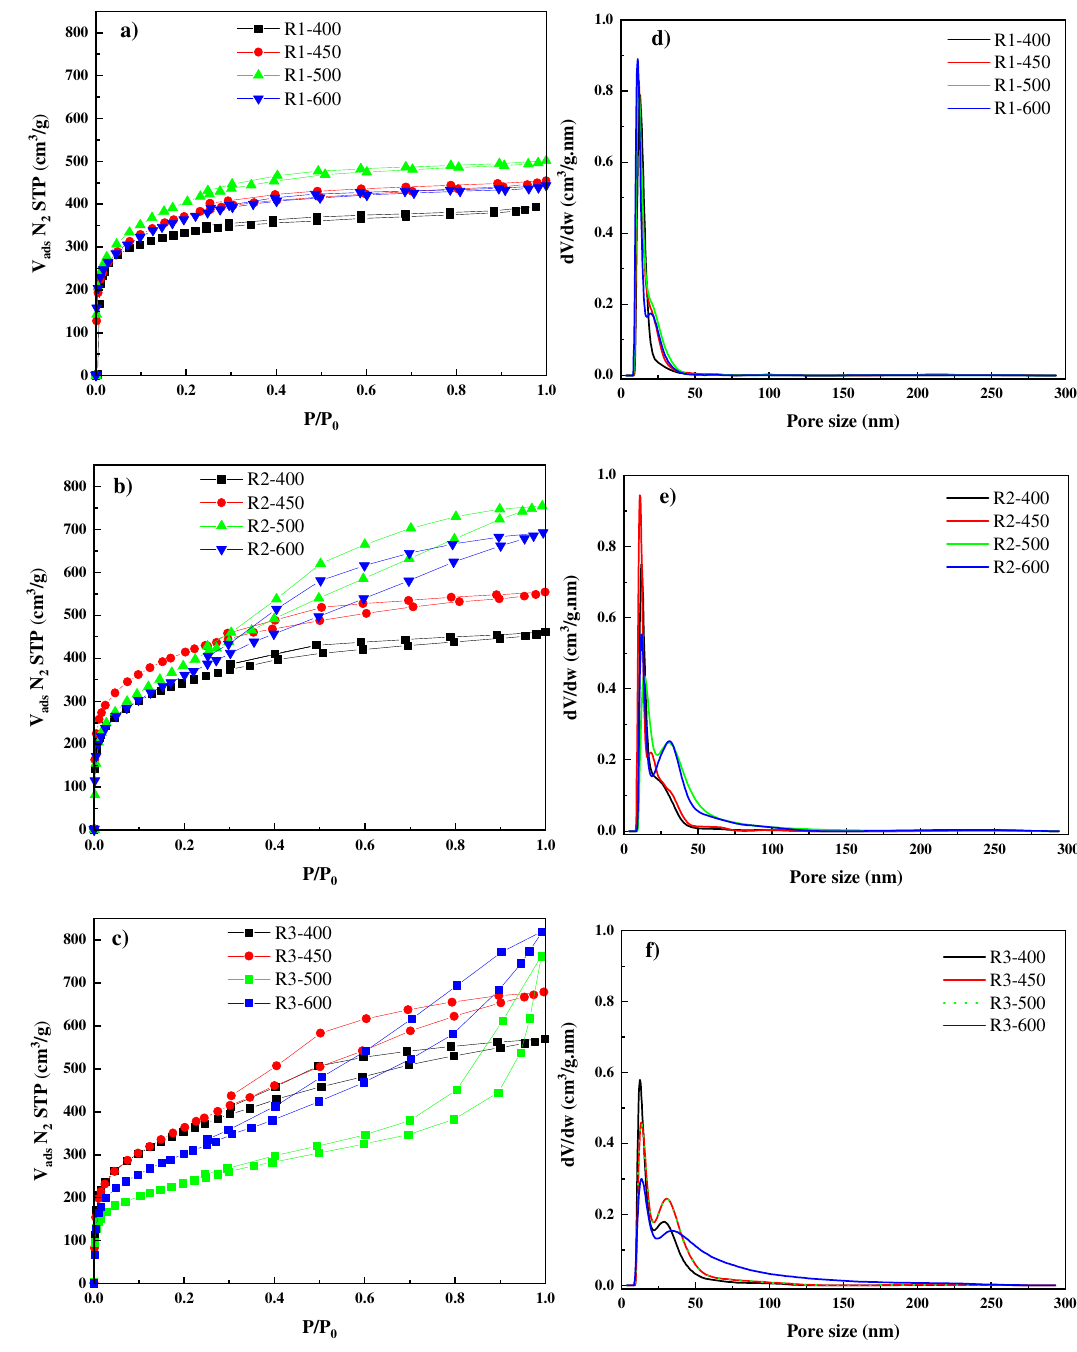
Figure 2. Adsorption–desorption isotherms of N 2 at − 196 ◦ C ( a – c ); and micropore size distribution ( d – f ) of activated carbons from STLs at different impregnation ratios and activation temperatures. Figure 2b represents the adsorption isotherms of samples prepared with an impreg- nation ratio of (2:1) at different activation temperatures. The activated carbon obtained at 400 ◦ C provides isotherm type I(b) which is typical of microporous materials where micropore filling may take place by primary filling at very low relative pressure. The activated carbons obtained at higher temperatures, exhibit a combination of type I and type IV(a) isotherms [59]. This indicates the presence of micro and mesoporosity leading to a gradual increase in adsorption after the initial filling of the micropores. The isotherms exhibit type H4 hysteresis, typical for slit-shaped